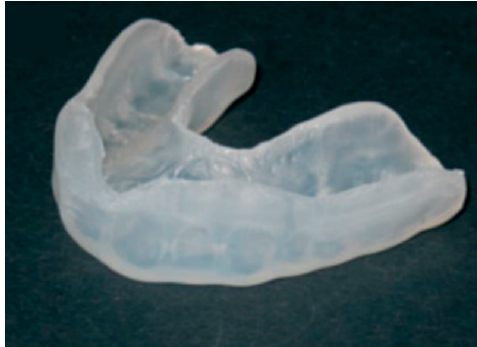
Figure 7. A custom-made mouthguard for the upper jaw ex-situ (adapted) [48]. Copyright Wiley-VCH Verlag GmbH & Co. KGaA. Reproduced with